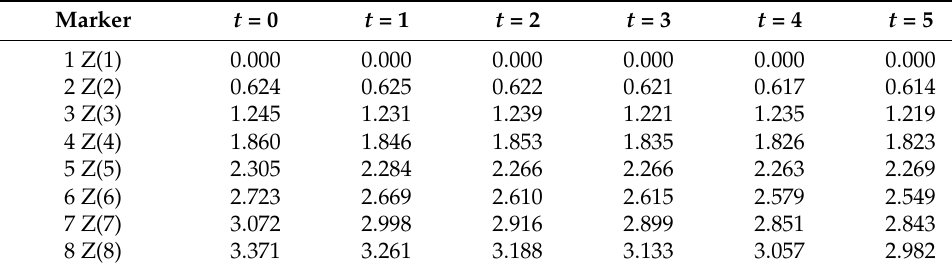
Table 2. Z coordinates of the markers ( m